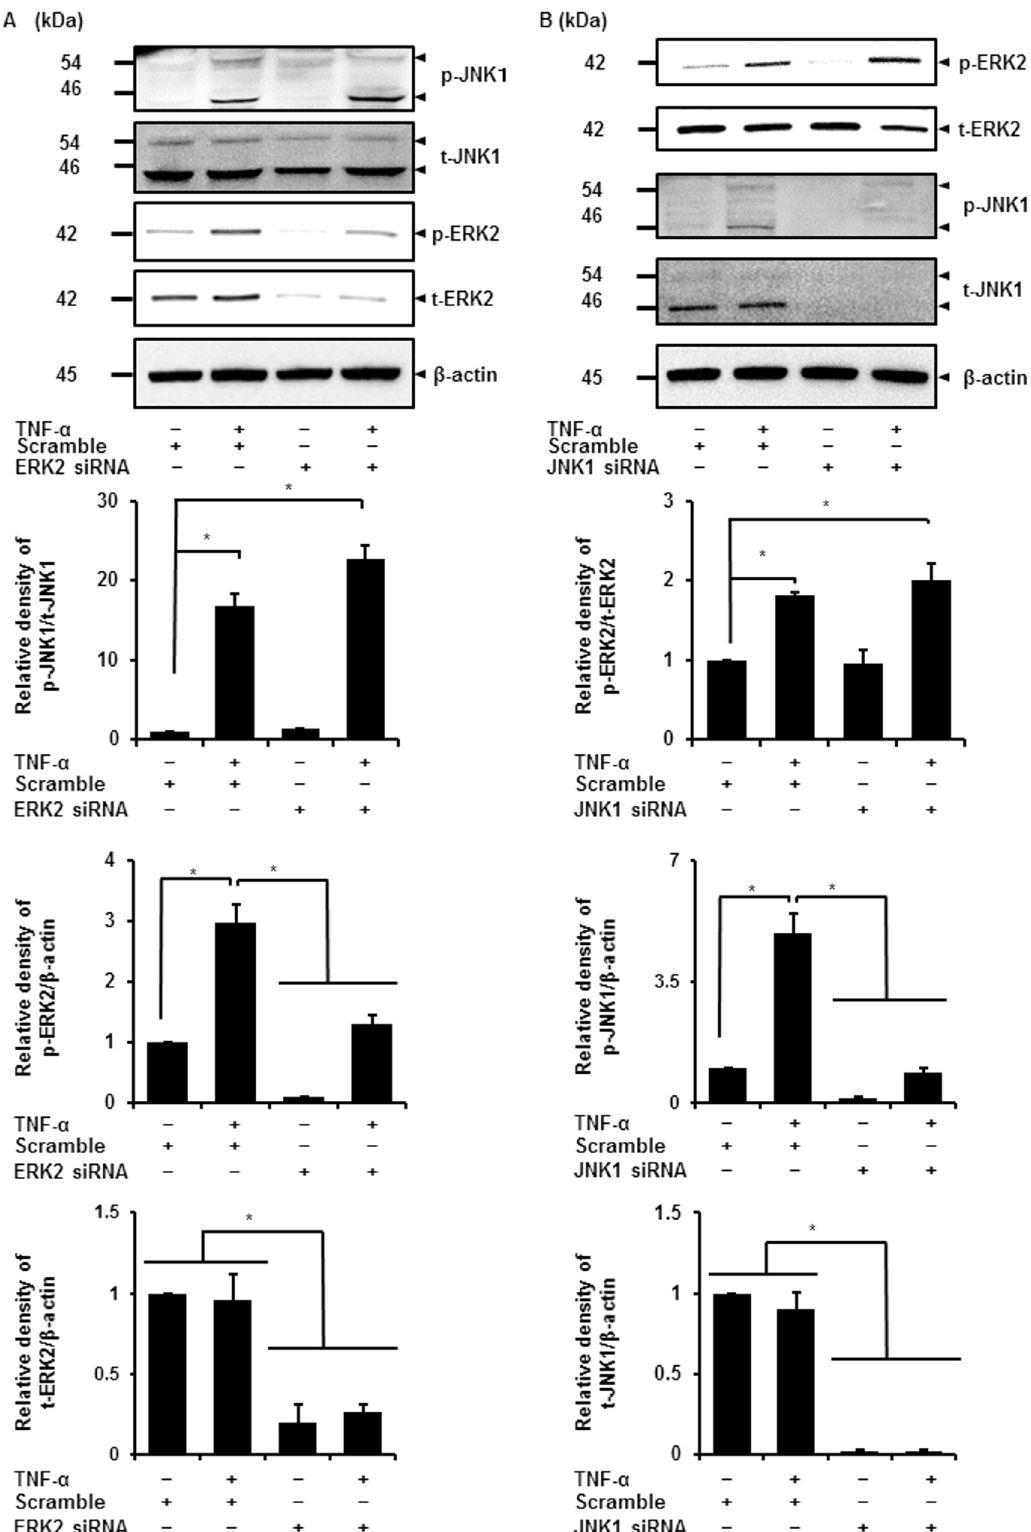
Fig 5. Parallel activation of ERK2 and JNK1 contributes to TNF- α -induced IL-8 expression. (A) Expression of phosphorylated JNK1 (p-JNK1), total JNK1 (t-JNK1), phosphorylated ERK2 (p-ERK2), total ERK2 (t-ERK2), and β